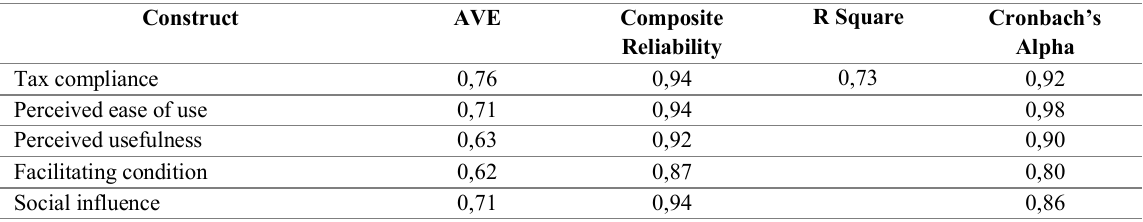
Table 1: Validity and Reliability Test